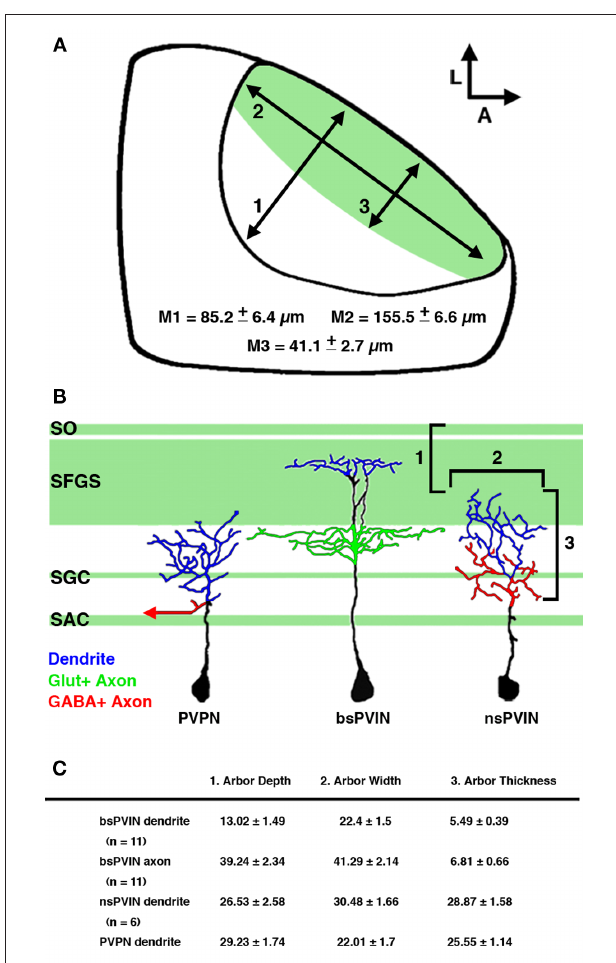
FiGure 10 | Summary of cell types labeled by the dg4ii plasmid. (A) Schematic of tectal anatomy and the relative sizes of the neuropil and primary retinorecipient laminae in the 5-dpf larvae. Measurements: (1) the maximum length of the tectal neuropil in the plane of the synaptic layers. (2) The maximum thickness of the neuropil in the axis perpendicular to the synaptic layers. (3) The maximum thickness of the primary retinorecipient layers (SO + SFGS). Note that these are maximum measurements at the center of the neuropil and the neuropil thickness is reduced at the edges. (B) Schematic traces of the cell types labeled by the dg4ii expression system and relative position of tectal neurite arbors. Note that nsPVINs an PVPNs primarily arborize in laminae that are primarily non-retinorecipient, whereas bsPVIN dendrites specifically target the SFGS layer. Dendrites are color coded in blue, glutamatergic axons in green (including retinal afferents indicated by green shading), and GABAergic axons in red. (C) Summary of morphological features that distinguish the three cell types identified. Arbor depth indicates the most superficial extent of the arbor as measured from the dorsal surface of the SO. Arbor width is the maximum measured distance in the plane of the synaptic layers. Thickness is the maximum length measured in the axis perpendicular to the synaptic layers. Data expressed as mean ±